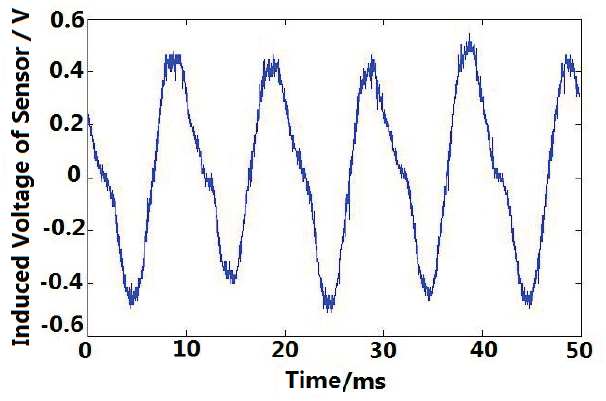
Figure 19. Angular acceleration of a single-phase asynchronous